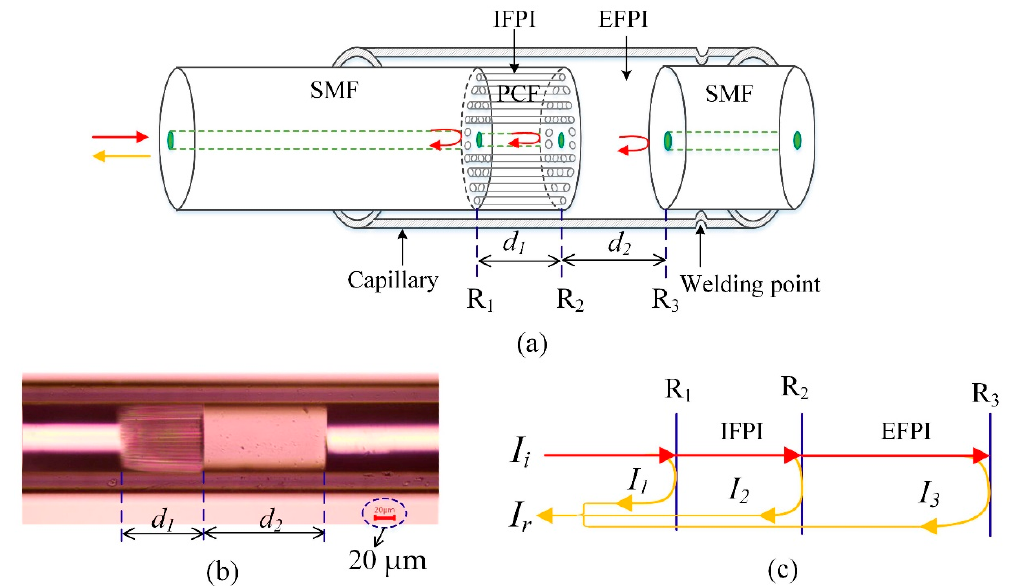
Figure 1. Schematic diagram of the CFPI sensor structure. ( a ) Concept diagram of the sensor structure; ( b ) microscope image of the fabricated sensor; ( c ) optical path illustration of the sensor.